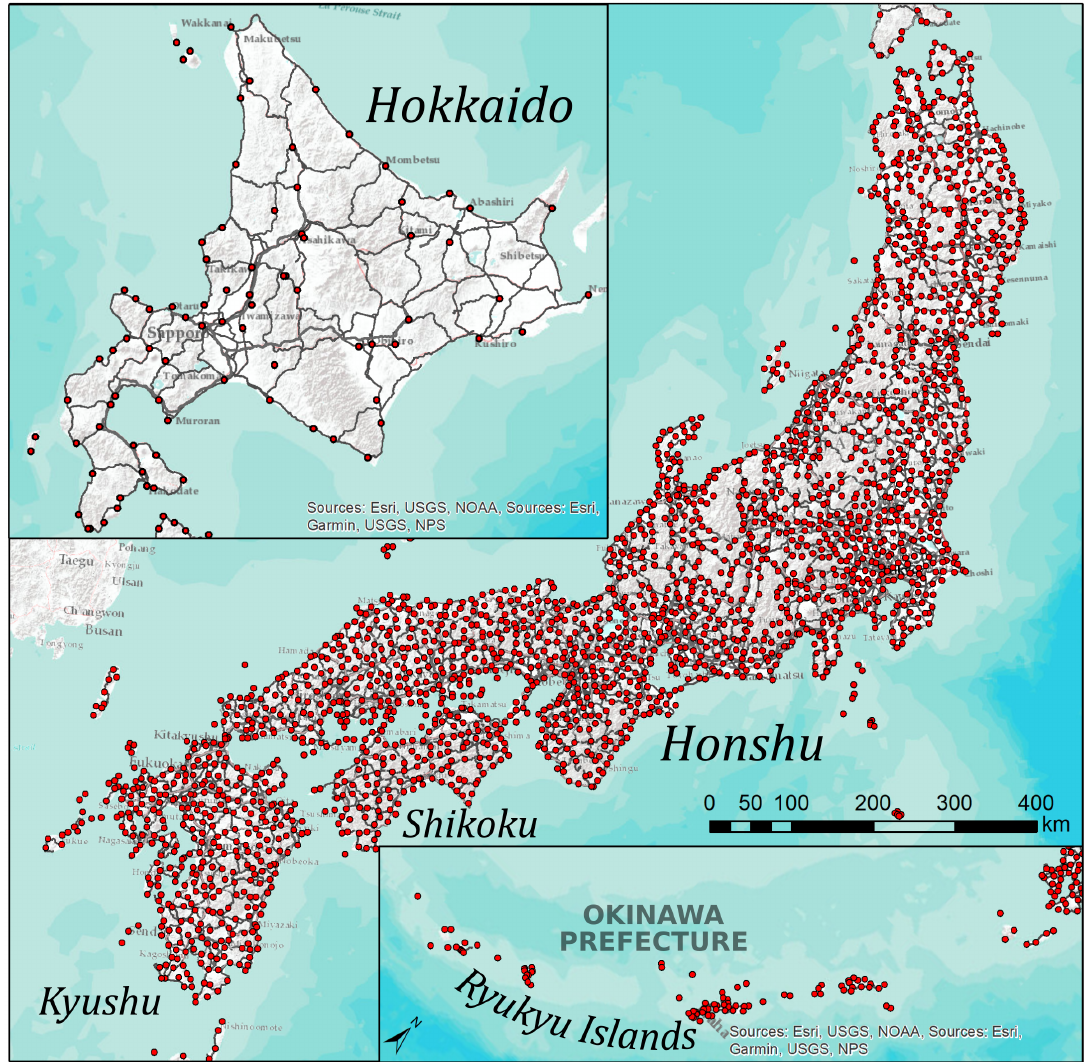
Figure 1. LAJ localities and the network of main roads in Japan. The mapping scale of the rather scattered Ryukyu Islands is smaller by a factor of